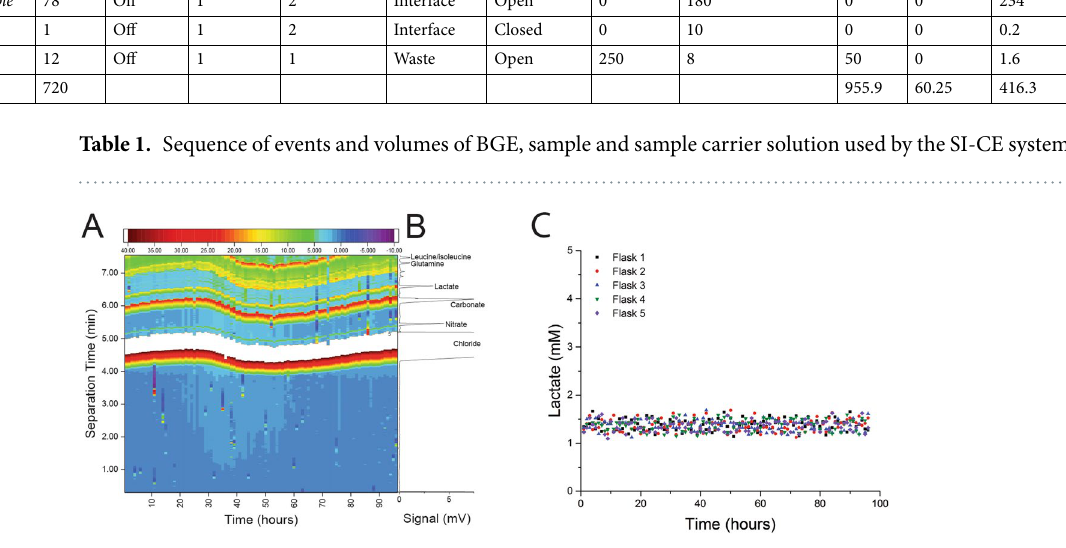
Figure 2. ( A ) Repeatability in the detection of analytical targets in RPMI-1640 cell culture media with 10% FCS (without cells) in one flask over continuous 4 days, ( B ) corresponding electropherogram showing chloride, nitrate, carbonate, lactate, and amino acids glutamine and leucine/isoleucine. Conditions: 80 cm × 50 μ m I.D. × 350 μ m O.D. fused silica capillary coated with HDMB/PSS/HDMB; BGE: 35 mM Tris/35 mM CHES, pH 8.9 with 0.025% PEI; + 28 kV, C: Repeatability of lactate concentrations in RPMI-1640 cell culture media with 10% FCS (without cells) in five flasks over continuous 4